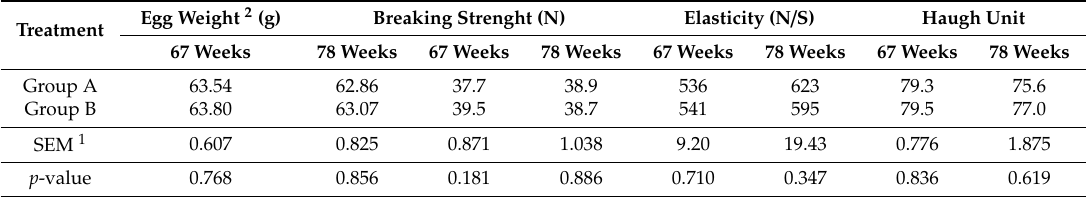
Table 8. Quality parameters of eggs from 67 and 78 weeks age laying hens fed a commercial diet (Group A) or a soy-free diet + live larvae (Group